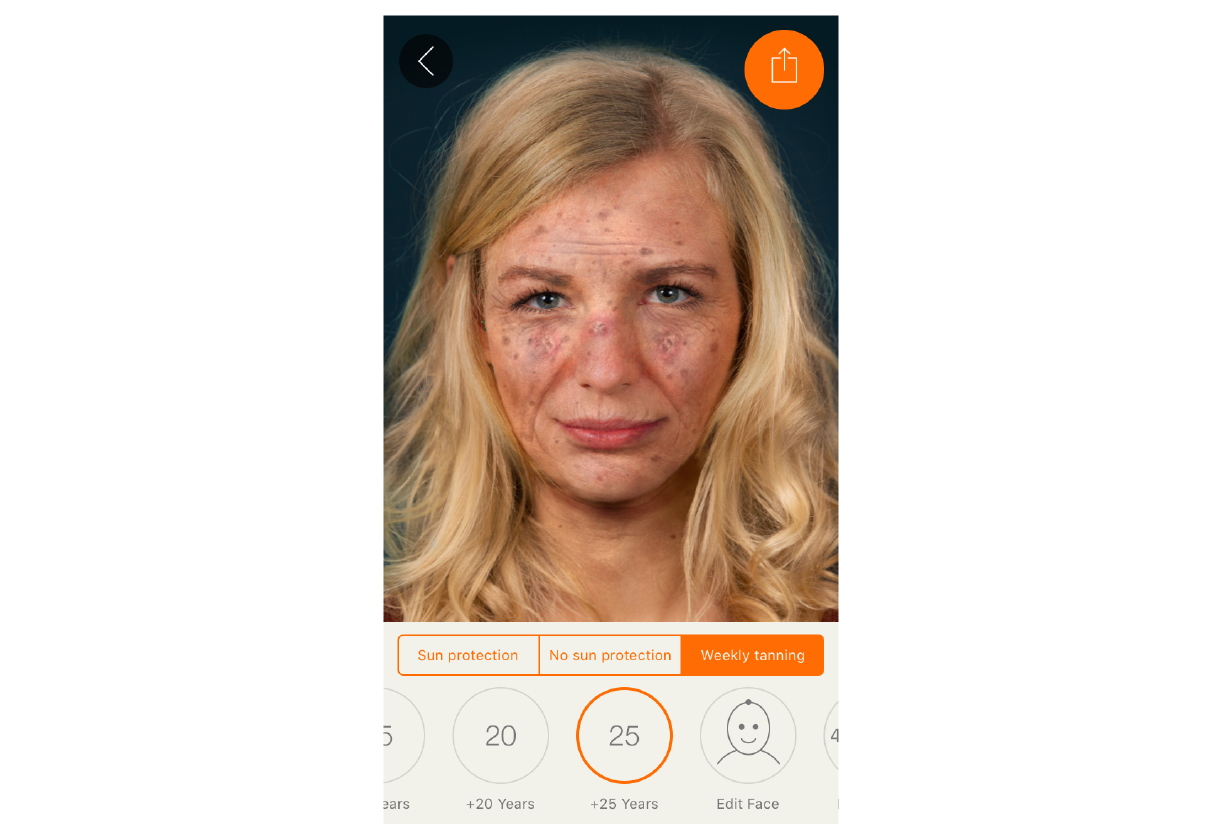
Figure 3. Effect view of the app: weekly tanning for 25 years (maximum effect) with a total of 3 actinic keratoses visible, multiple solar lentigines, age spots, and prominent solar elastosis.